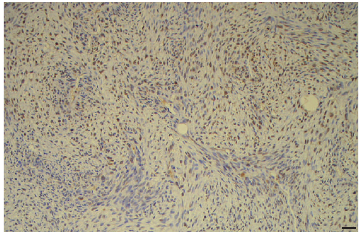
Figure 3: Homogenous expression of survivin in MPNSTs. Scale bar represents 20 µ m.